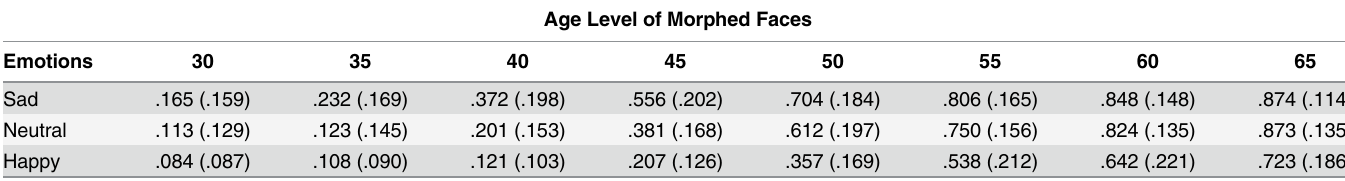
Table 1. Means and standard deviations of the proportion of old